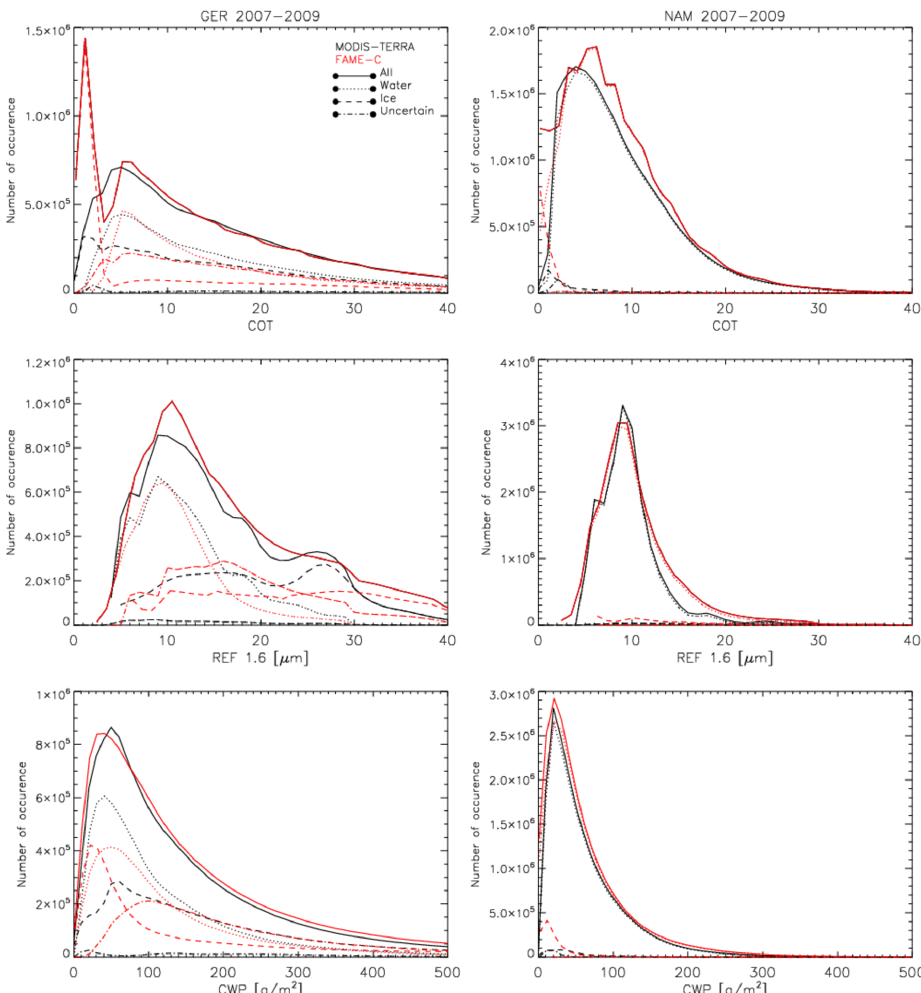
Figure 7. Frequency histograms of the pixel-based retrieved cloud optical and microphysical properties ∗ of FAME-C and MODIS-Terra for the GER and NAM regions as presented in Fig. 5. ∗ Cloud optical thickness (COT), effective radius using channel 1.6µm (REF16) and cloud water path